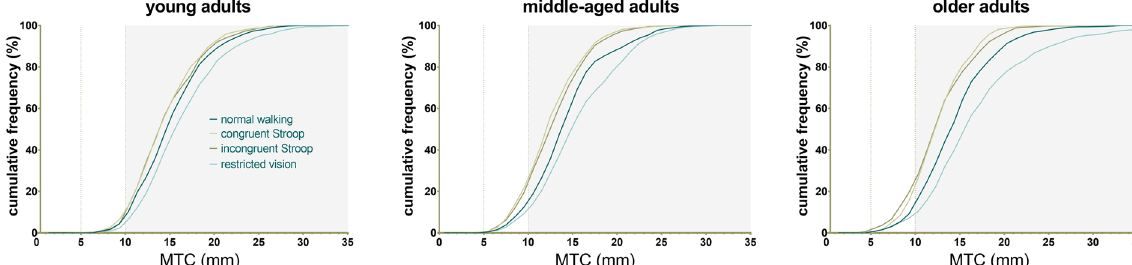
Figure 5. Minimum toe clearance cumulative relative frequency graphs for each age group. Each individual contributed 25 consecutive MTC values to the group histogram. Dotted lines indicate MTC thresholds of 5 mm and 10 mm, while shaded area indicates MTC values over 10 mm. MTC; minimum toe clearance.